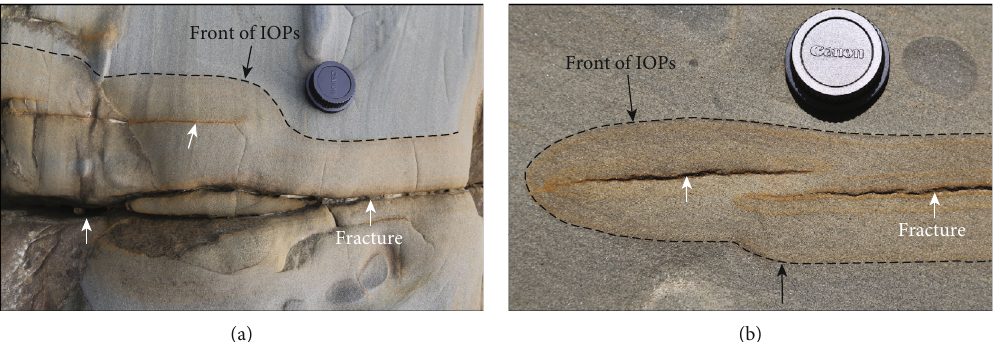
Figure 4: (a) Example of fracture tip interaction, where the front of the iron oxide precipitates (black, dashed line) curves out where the fracture tips overlap; Hokianga, New Zealand. (b) Example of how iron oxide precipitates respond to fracture-tip interaction: the front of the iron oxide precipitates (black, dashed line) narrows as the fractures (white arrows) tip out; Hokianga, New Zealand.